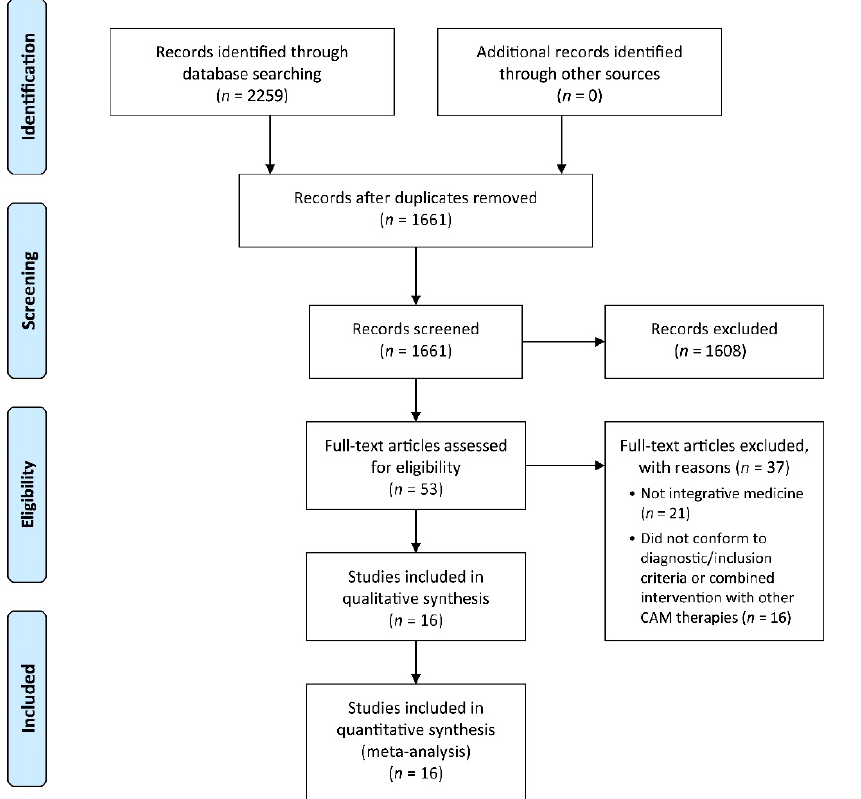
Figure 1. Flow chart of the study selection process.